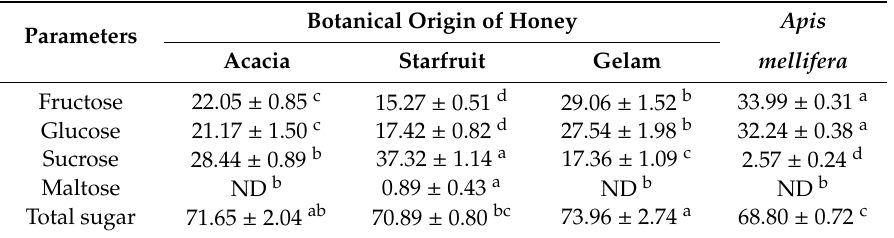
Table 2. The concentration of sugar (g / 100 g) in honey samples from di ff erent botanical